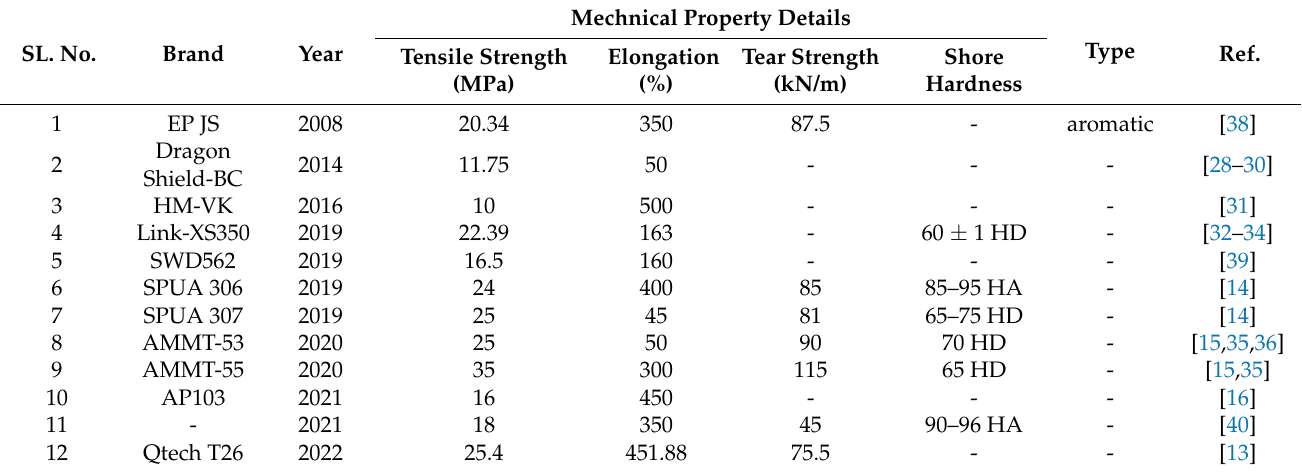
Table 1. Mechanical properties of different brands of